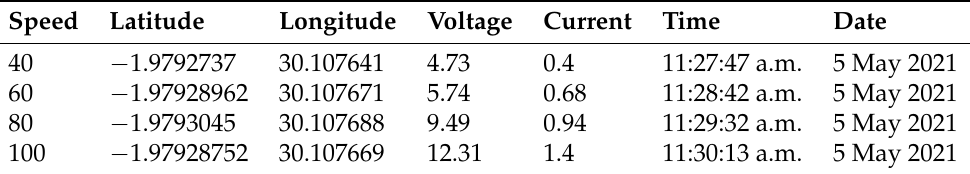
Table 2. Scenario 1.